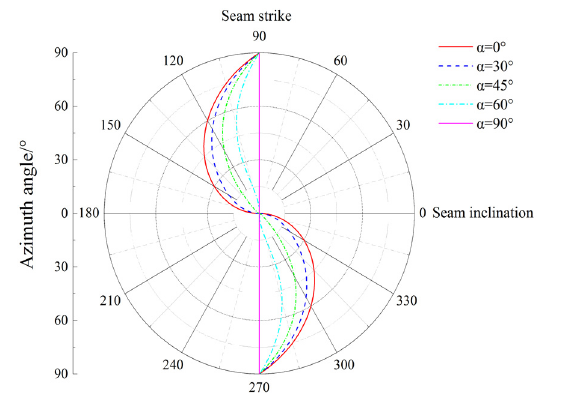
Figure 14. Relationship between the initial cracking location and the major principle stress azimuth angle.